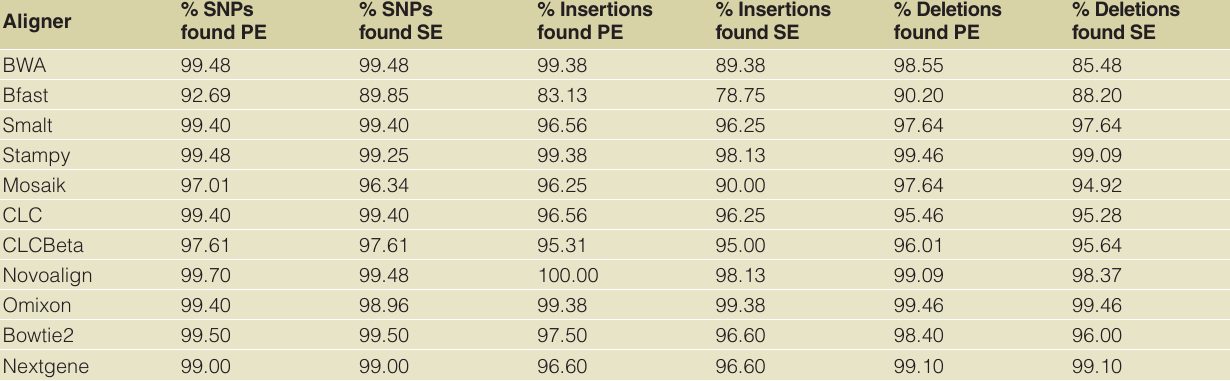
Table 4. Downstream detection sensitivities by mutation type. Total percentage of SNPs and INDELs detected across the 67 groups of simulated Illumina reads following alignment with each aligner in single and paired-end mode. Aligner